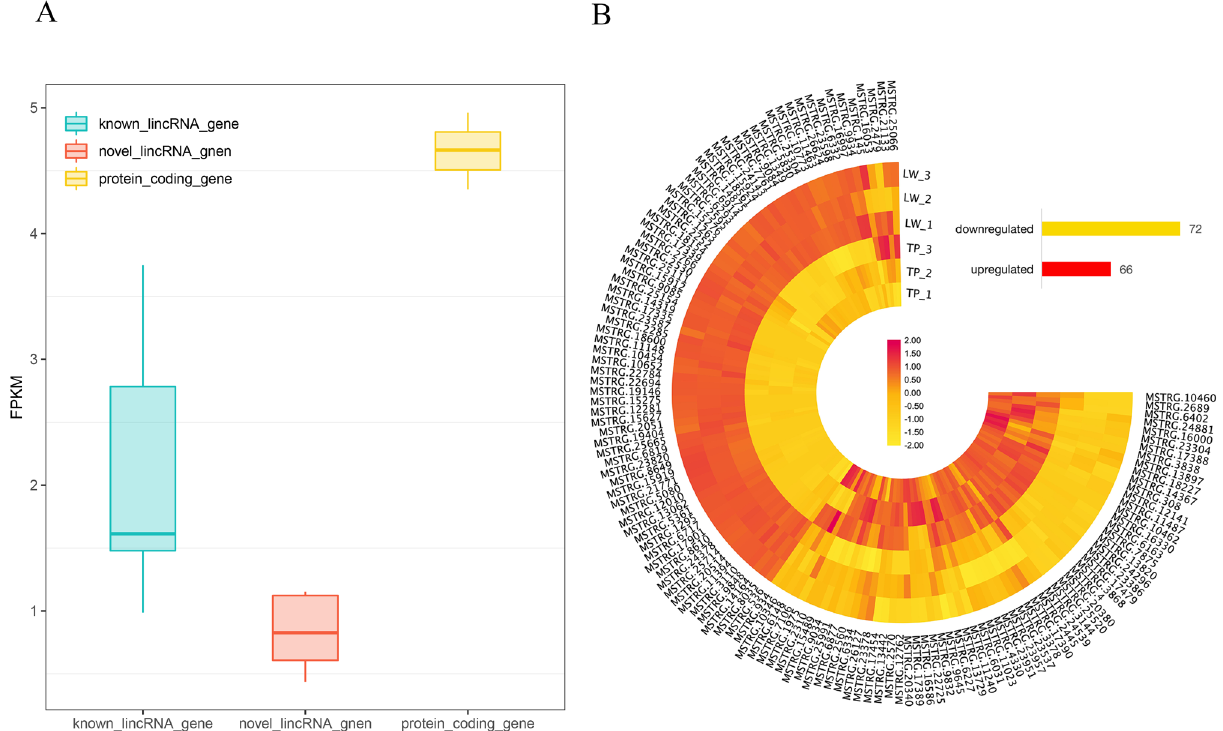
Figure 3. The results of expression analysis. ( A ) Expression levels of different lincRNA and protein-encoding genes. ( B ) Differential expression analysis of differential lincRNAs, the bar code represents the color scale of the log 10 (FPKM)